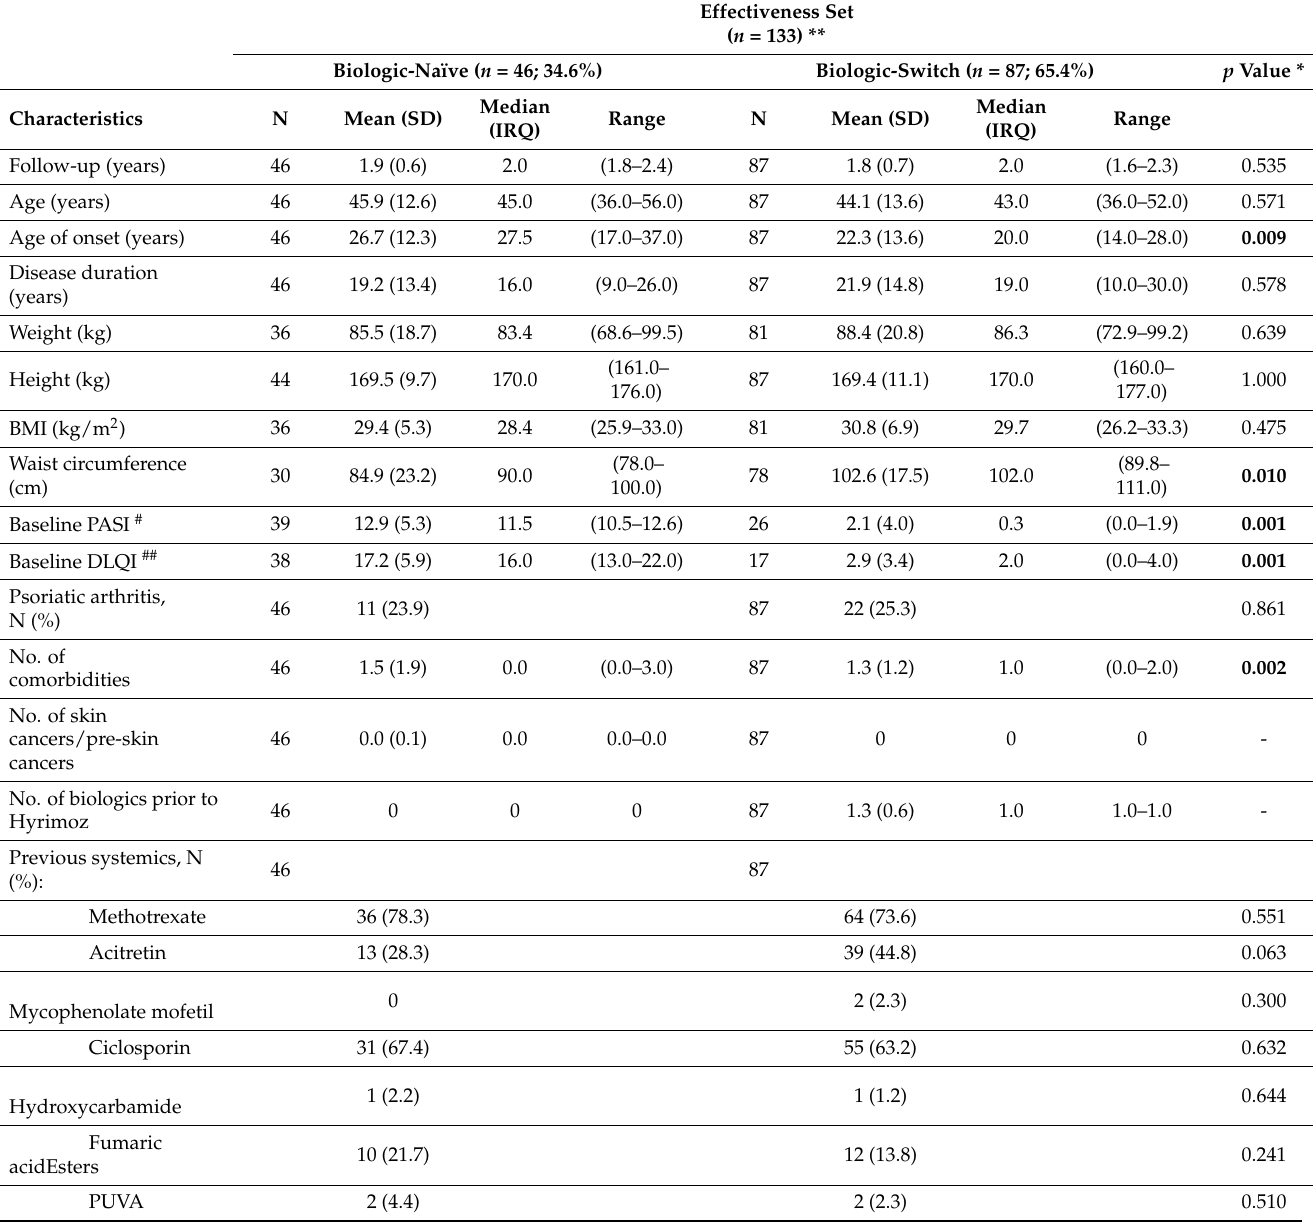
Table 5. Baseline demographics and clinical characteristics of the effectiveness